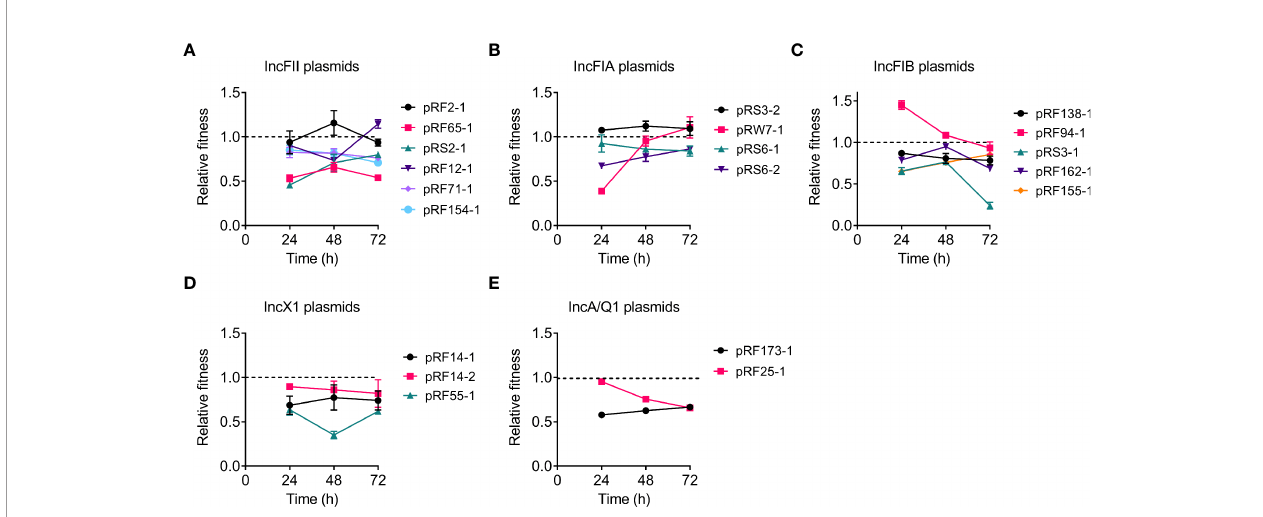
FIGURE 2 | Effects of tet (X4)-positive plasmids on the fi tness cost of transformants. Transformants carrying tet (X)-positive IncFII (A) , IncFIA (B) , IncFIB (C) , IncX1 (D) , or IncA/Q1 (E) plasmids were competed with their parental strain E. coli TOP10, respectively. The relative fi tness of transformants was detected every day (from 24 to 72 h). All competition assays were performed with three biological replicates.